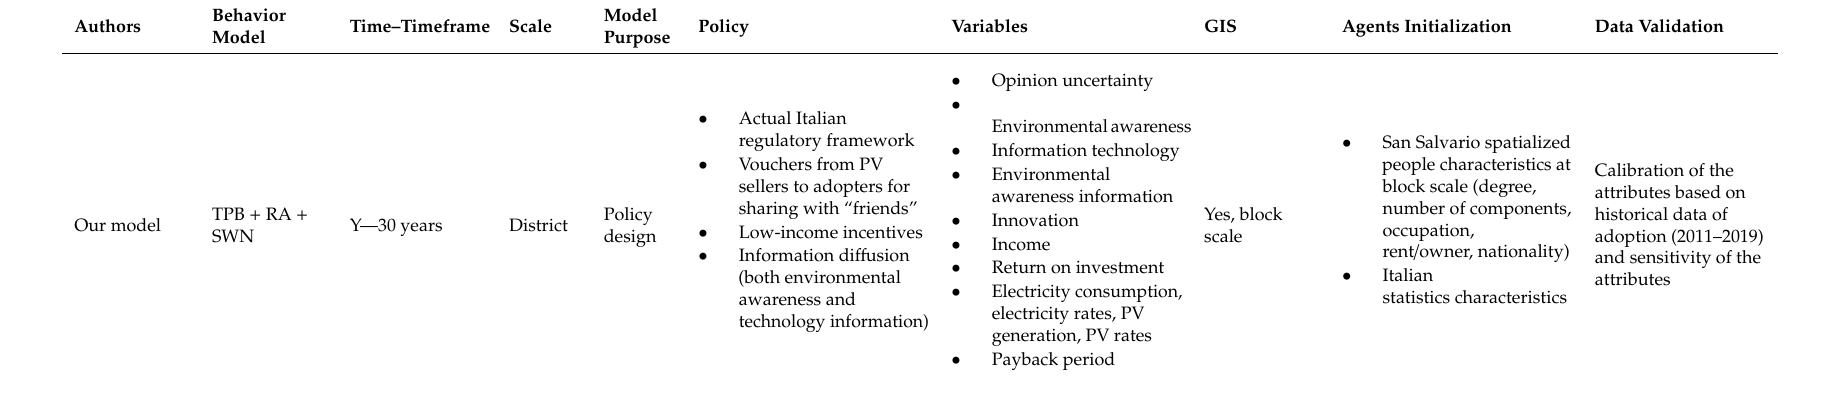
Table 2. The framework of the model performed in the present research based on the literature